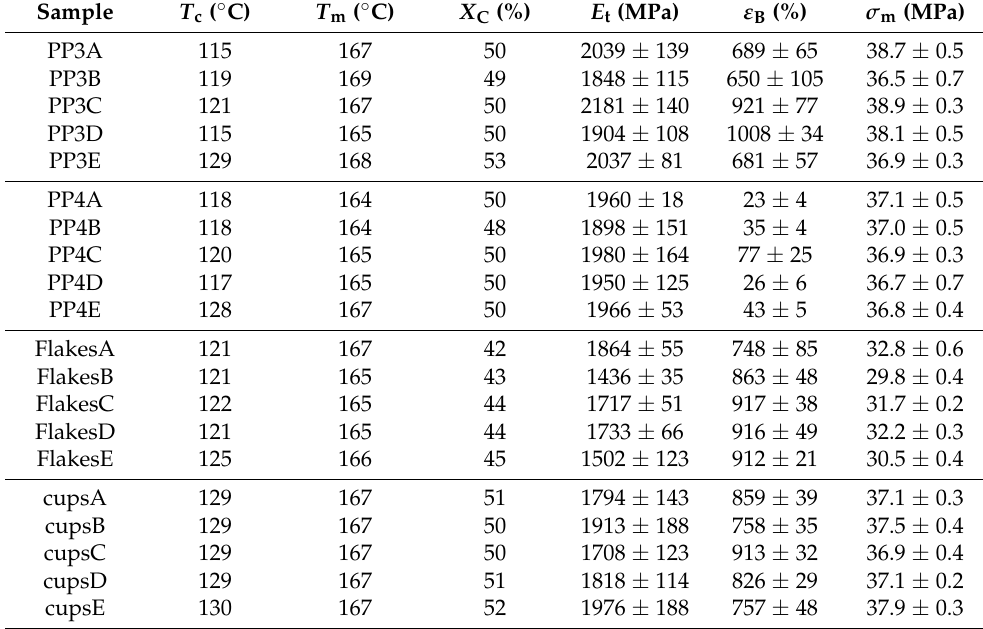
Table 2. Crystallization temperature ( T c ), melting temperature and crystallinity (2nd heating) of all samples obtained from differential scanning calorimetry (DSC) measurements; mechanical properties (tensile modulus, elongation at break and tensile strength) obtained from tensile test.